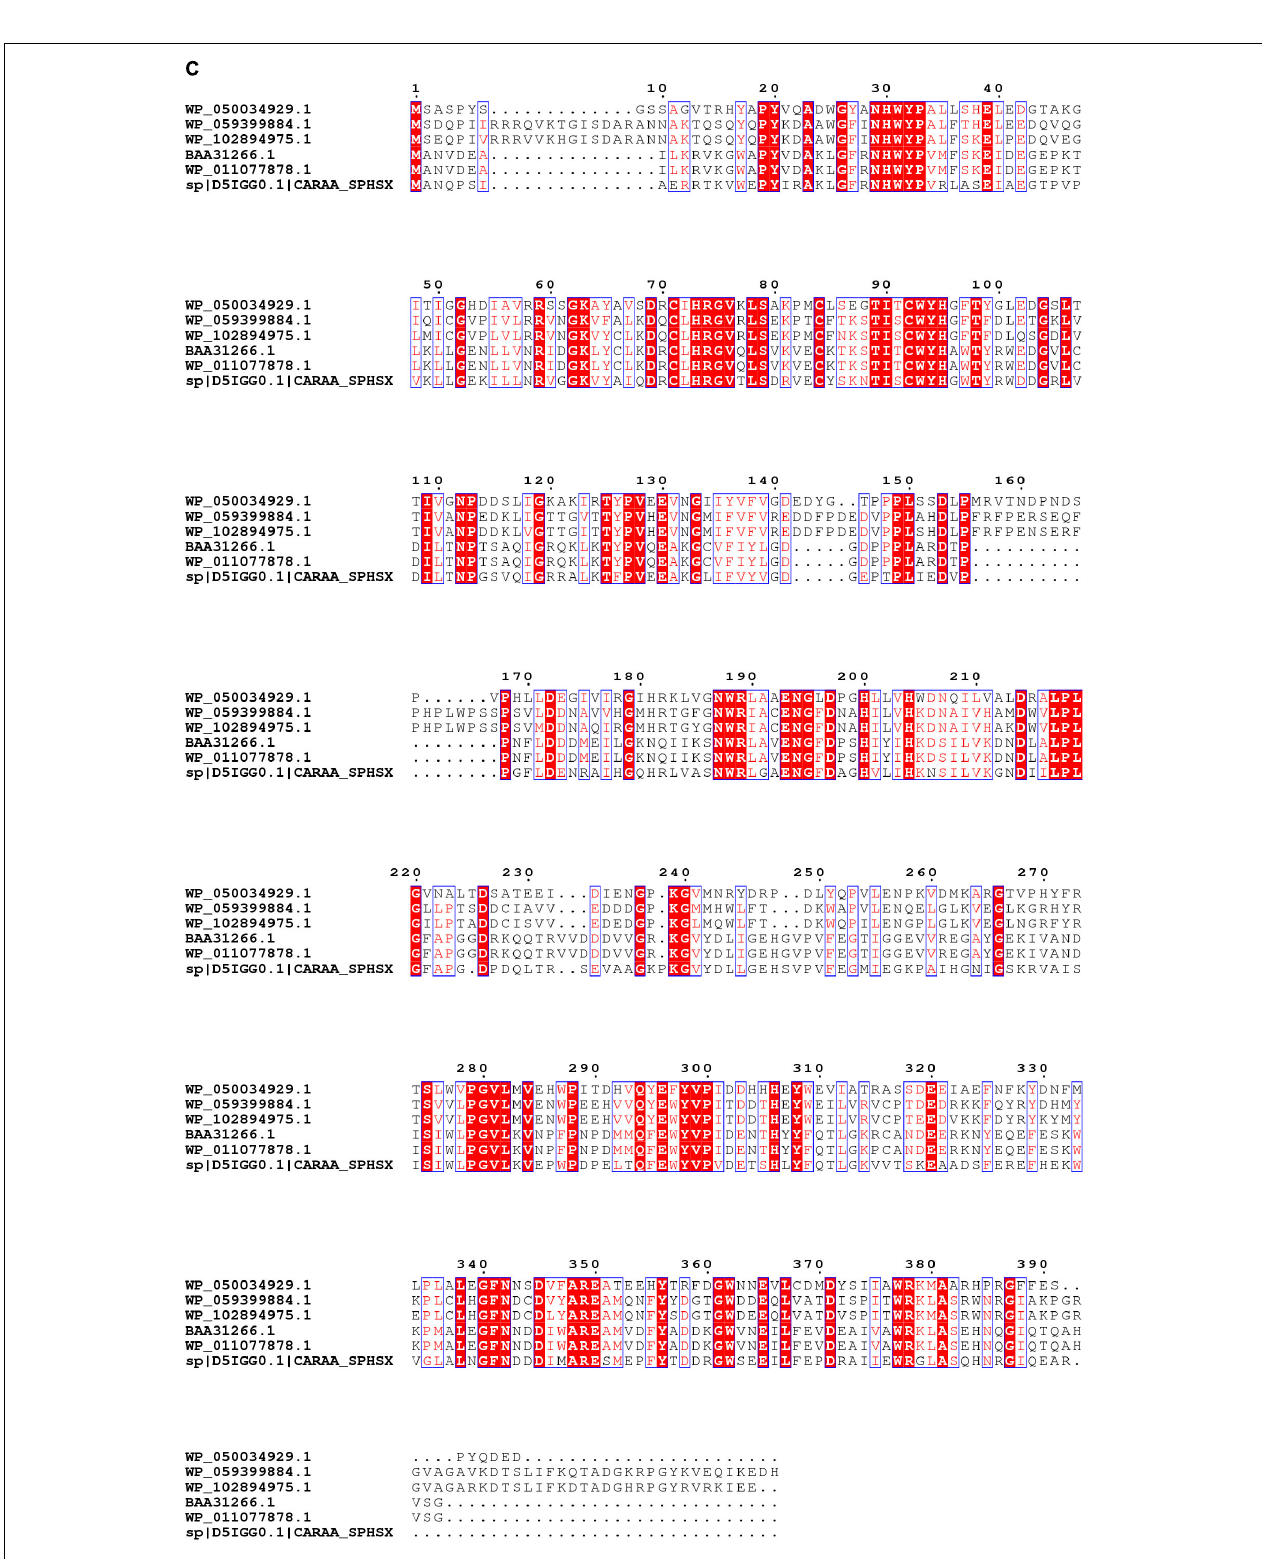
FIGURE 5 | Sequence alignment of 1892 (A) , 1893 (B) and 1894 (C) , and their homologs from Pseudomonas , Mycobacterium sp., Mycobacterium vanbaalenii , Rhodococcus sp., Rhodococcus jostii , Sphingomonas sp., etc. Sequence alignment was performed using the ClustalW (v. 2.0) and ESPript programs. Conserved sequences are indicated by boxes, and similar sequences are indicated by colored